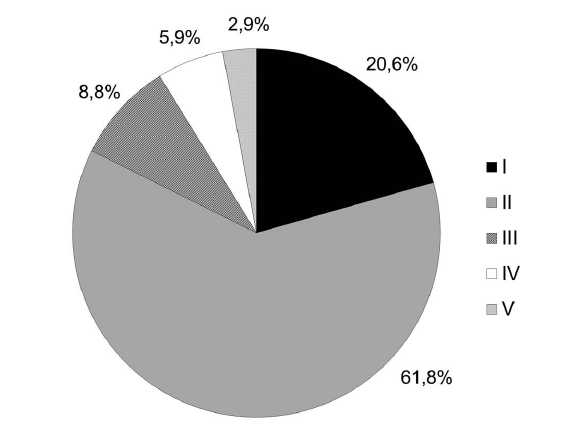
Fig. 5. – Percentage of recorded taxa belonging to the following groups of geographical distribution. I, Mediterranean endemic; II, Mediterranean and Atlantic Ocean; III, Mediterranean, Atlantic and Indo-Pacific Ocean; IV, Mediterranean, Atlantic and Artic Ocean; V,